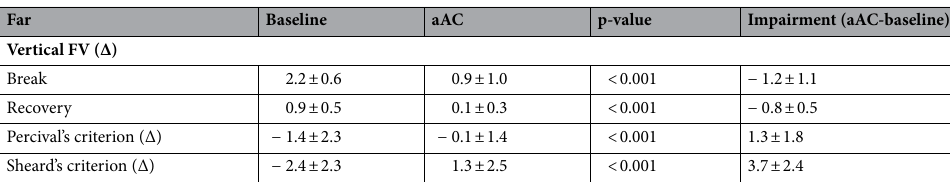
Table 2. Mean values and standard deviations for distance vertical fusional vergences and Percival’s and Sheard’s criteria, measured at baseline and after alcohol consumption (aAC) for a BrAC of 0.40 mg/l. Mean impairment value for each parameter and p-values of the mean comparisons are